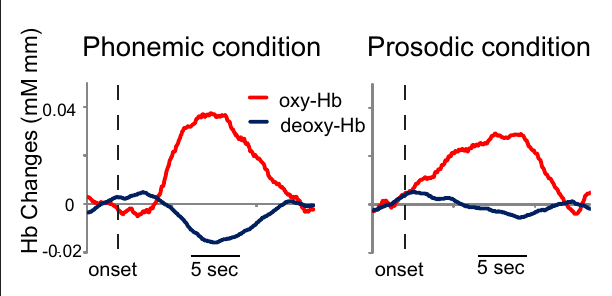
FIguRe 3 | Hemodynamic responses to phonemic and prosodic sound changes. Grand averaged time course of Hb collapsing across all the channels each for the phonemic and prosodic condition. Dashed line indicates the onset of target block and vertical line is 5 s of